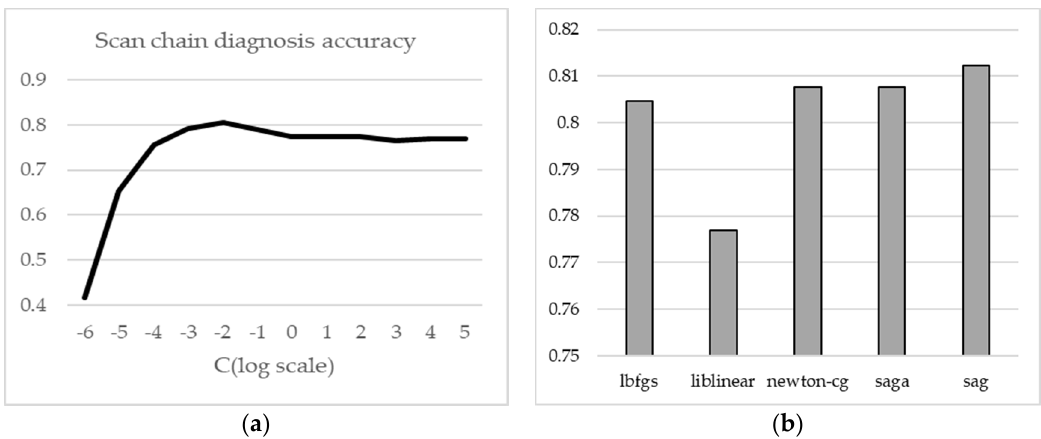
Figure 10. Accuracy of scan ‐ chain diagnosis depending on regularization strength value and solvers on B12: ( a ) accuracy of scan ‐ chain diagnosis depending on the regularization strength value (C); ( b ) accuracy of scan ‐ chain diagnosis with various solvers at the inverse of regularization strength value e − 2 .